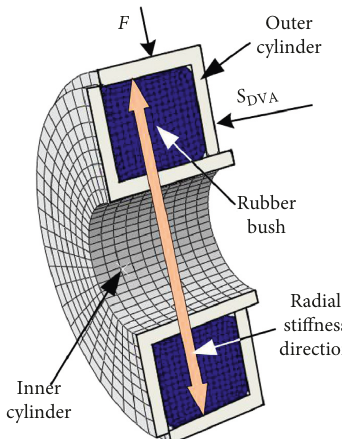
Figure 12: Finite element model of a single rubber bush.